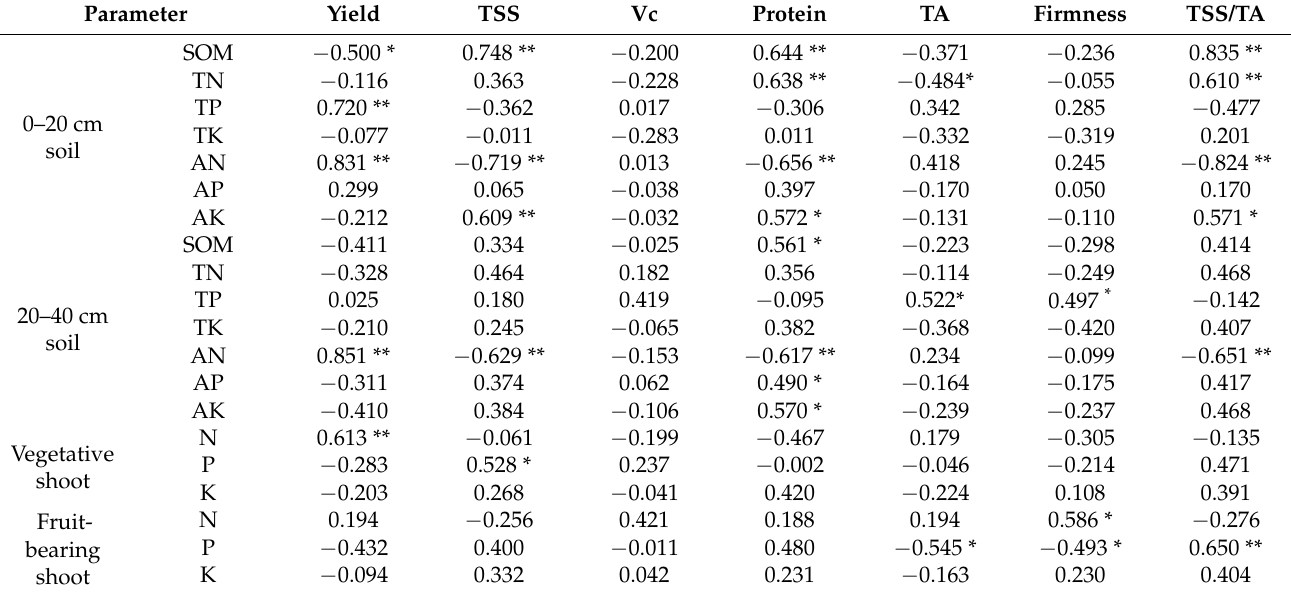
Table 4. Correlation analysis between soil properties, leaf NPK contents, fruit yield and